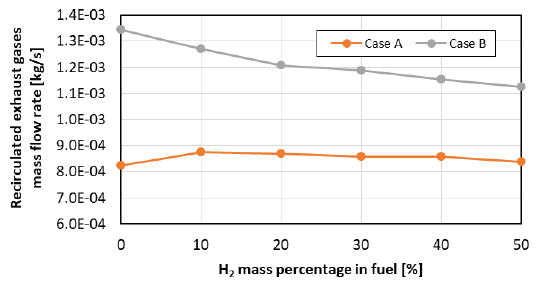
Fig. 6. Recirculated exhaust gas mass flows The simulations yielded the recirculated exhaust gas mass flows for each of the combustor cases. IFGR ratios were calculated from equations 2 and 3. IFGR% stands for the ratio of the recirculated exhaust gas mass flow to the air mass flow passing through the mixing pipe, while IFGR%* stands for the ratio of the recirculated exhaust gas mass flow to the exhaust gas mass flow leaving the